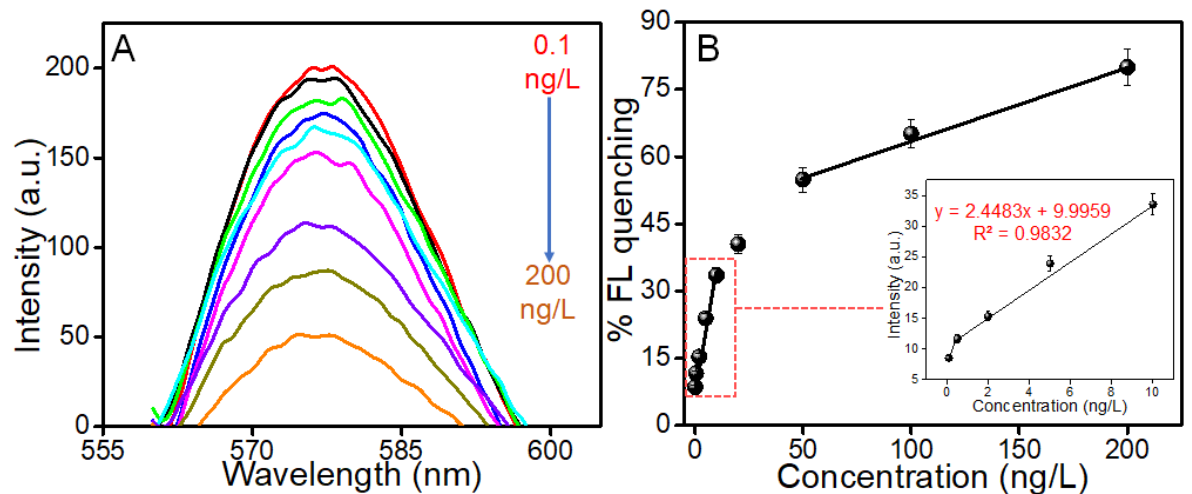
Figure 9. Fluorescence quenching spectra at different OTA concentrations ( A ); calibration plot (%FL quenching vs. OTA concentrations) (0.1, 0.5, 2.0, 5.0, 10, 20, 50, 100 and 200 ng/L) measured at 554 nm for excitation and 578 nm for emission ( B ).